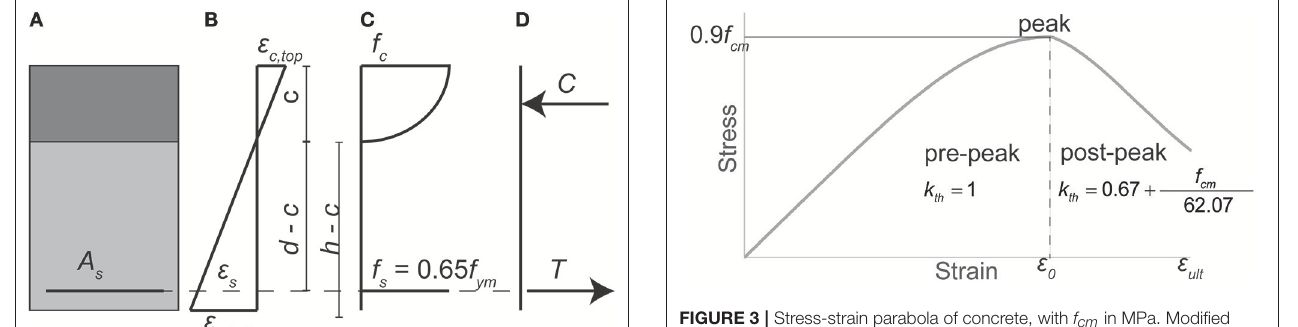
FIGURE 3 | Stress-strain parabola of concrete, with f cm in MPa. Modified from (Lantsoght et al.,